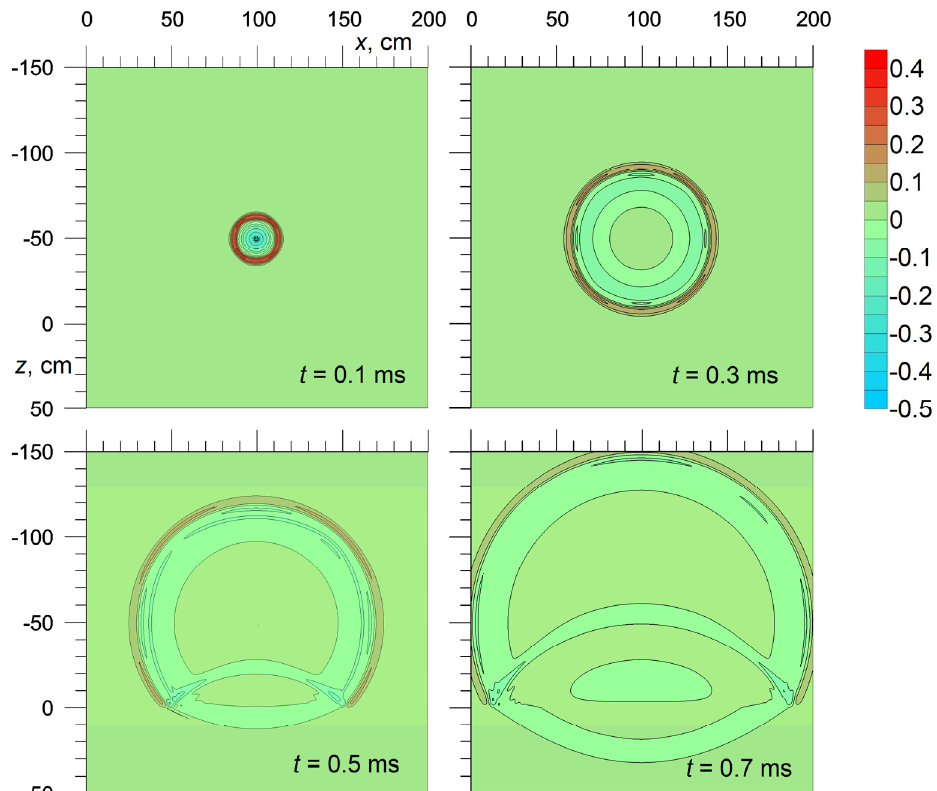
Figure 4. The field of dimensionless pressure difference ∆ p f / p 0 when the perturbation propagates from the source and passes/reflects through the boundary of two single-phase media for several time points. The color scale on the right shows a pressure level ∆ p l / p 0